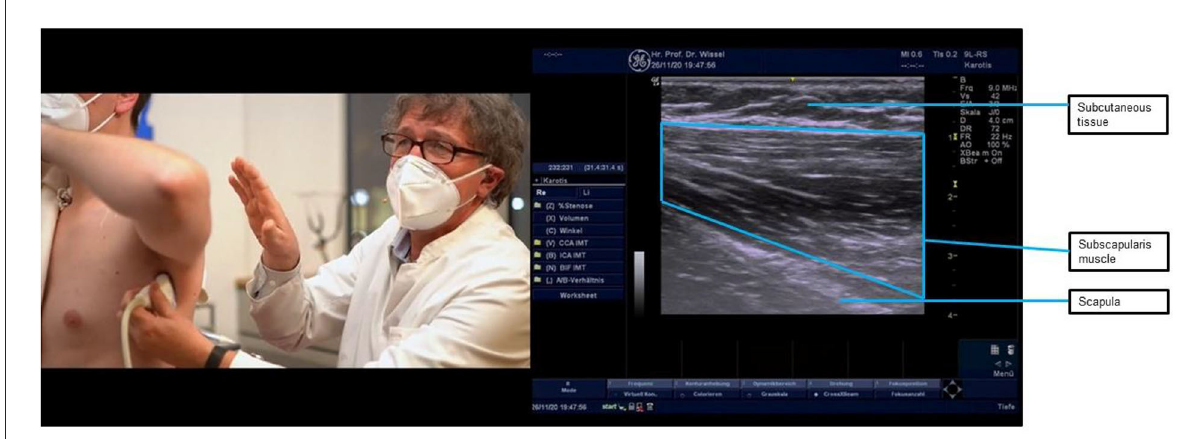
FIGURE5 Ultrasound probe placement and image of the subscapularis muscle. The subscapularis is the strongest inner rotator of the shoulder muscles. As the subscapularis muscle is located under the shoulder blade, ultrasound location requires elevation of the arm with probe placement in the axilla pointing toward the shoulder blade. The subscapularis muscle is visible as the striped structure in the ultrasound image, below the subcutaneous tissue at the top of the image. Injection of the subscapularis muscle requires two people—one to hold the arm while the patient is lying supine and one to hold the ultrasound probe and inject. Injecting behind the probe location shown above, aiming away from the thorax and toward the scapula, is the only safe approach as the ultrasound probe protects the thorax, and on the other side of the subscapularis lies the scapula, which cannot be harmed when